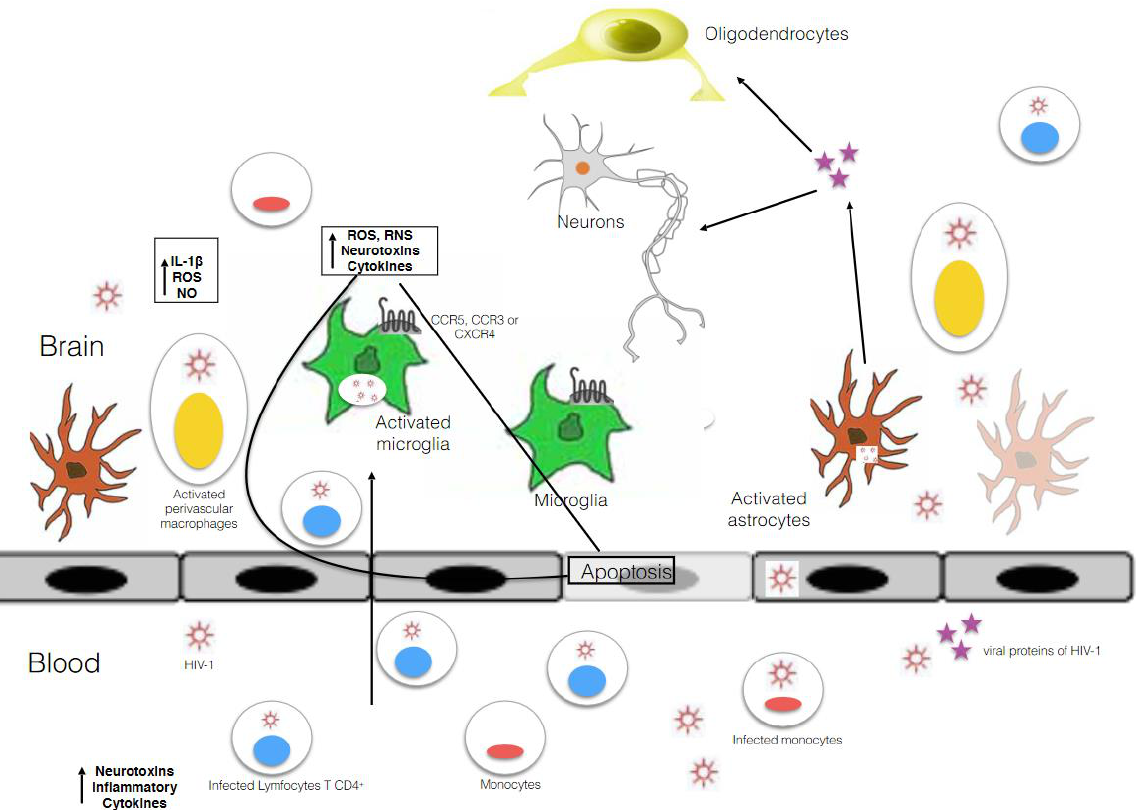
Figure 1. Schematic representation of the entry of HIV and its viral proteins into the brain. HIV enters the perivascular space (the main site for viral replication) by migration across the BBB via infected macrophages or blood lymphocytes or as free virions (viral particles) where it infects and activates macrophages, astrocytes, and microglia. The activation of these cells plays a key role in the release of proinflammatory cytokines and can amplify the alteration and permeability of the BBB. HIV-1 envelopes glycoprotein; attaches the virion to macrophages, astrocytes, and microglia; and induces the fusion of viral and cell membranes to initiate infection. It interacts with the chemokine receptor CCR5 or CXCR4 to allow viral entry by triggering large structural rearrangements and unleashing the fusogenic potential of gp41 to induce mem- brane fusion.